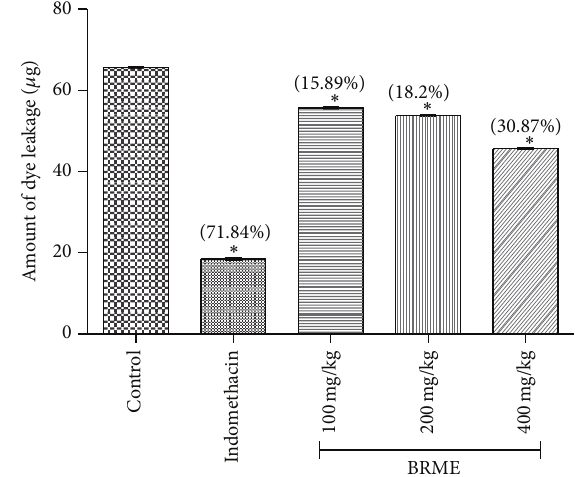
Figure 5: Effects of BRME and indomethacin in the acetic acid- induced vascular permeability. Values are expressed as means ± SEM ( 𝑛 = 6 ). ∗ 𝑃 < 0.05 , compared to the control group (one- way ANOVA followed by Dennett’s test). (%) represents percentage inhibition of dye leakage into peritoneum